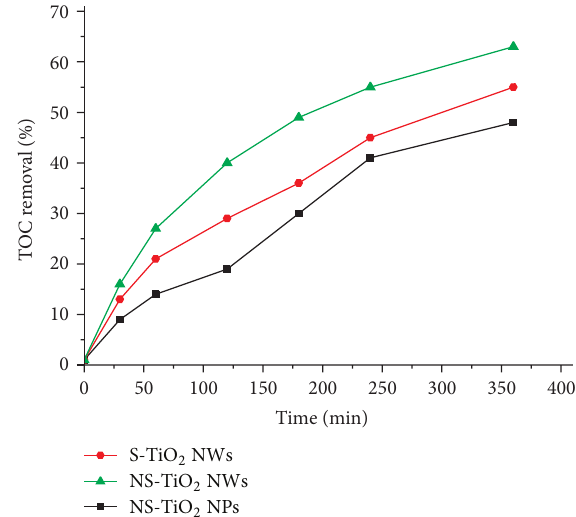
Figure 8: TOC removal rate as a function of irradiation time during mineralization of 5 mg L −1